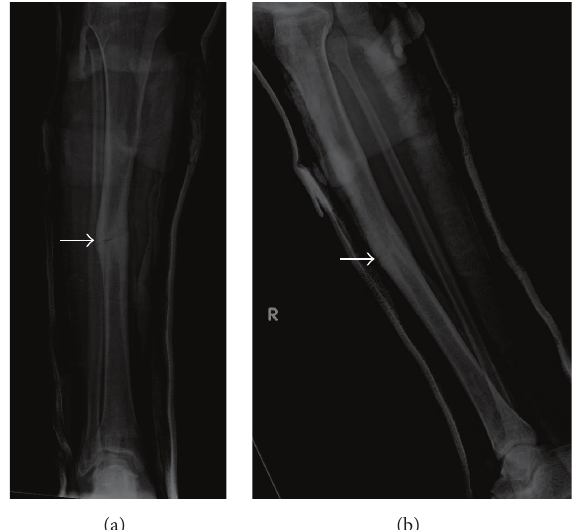
Figure10:YoungadultmalewithhistoryofRothmund-Thomsonsyndromediagnosedat2yearsofage.Findings:(a)satisfactoryalignmentof the now minimally displaced mid tibia diaphyseal fracture (arrow) on the AP projection after casting. (b) Lateral view also shows satisfactory alignment of the tibia diaphyseal fracture (arrow) after casting. Technique: (a) AP radiograph kVp = 60, mAs = 3, and (b) lateral radiograph kVp = 60, mAs =